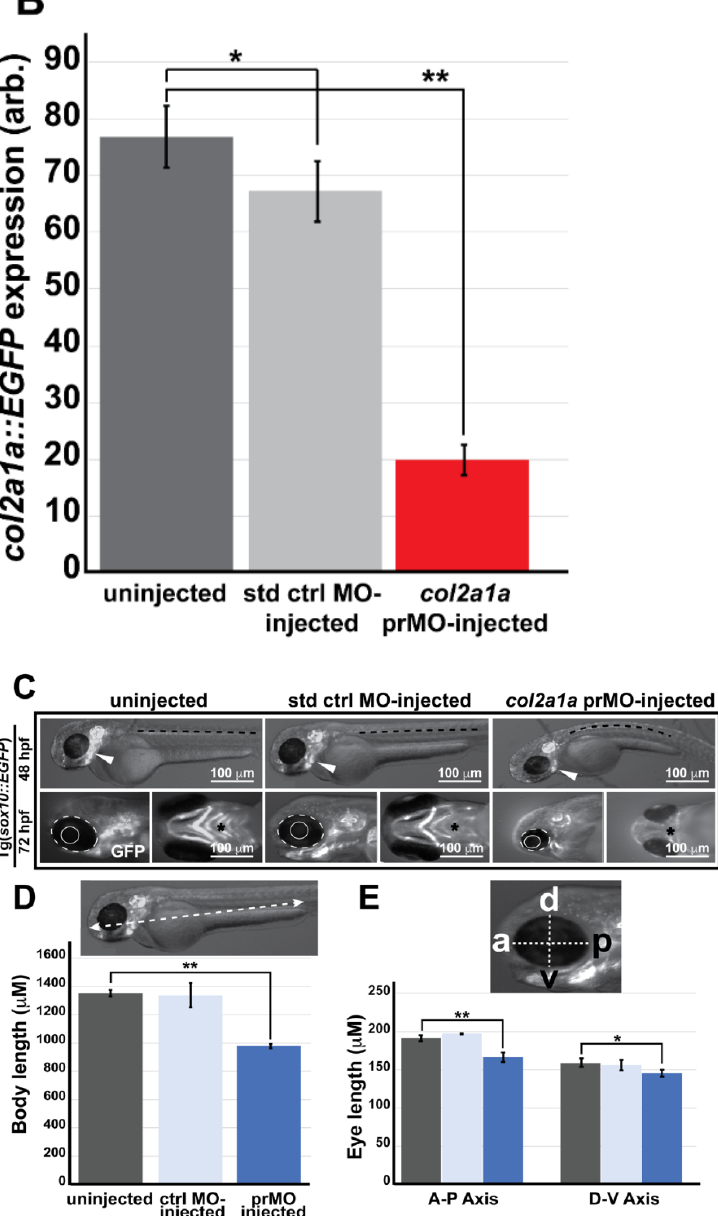
Figure 4. Col2a1a knockdown mimicked the characteristic features of human Stickler syndrome in zebrafish. A lissamine-tagged antisense MO targeting the promoter region (prMO) of col2a1a was injected into TgBAC( col2a1a::EGFP ) and Tg( sox10::EGFP ) embryos at the single-cell stage. Lateral FL microscopy images ( A ) show the loss of GFP reporter expression driven by the col2a1a promoter in TgBAC( col2a1a::EGFP ) transgenic fish (lower right panel) compared with uninjected and standard control (std ctrl) MO-injected embryos (upper right and middle panels, respectively). Quantification of this effect showed a significant loss of expression ( B ). MO-injected Sox10-positive transgenic zebrafish embryos showed skeletal defects, including scoliosis (upper right panel, dashed black line, ( C )) and significantly shortened body length ( D ), measured perpendicular to the spine from the tip of the epiphysis to the area above the urogenital opening (white dashed arrow (inset, D ), delayed neural crest-derived jaw development (white arrowhead, upper right panel and black asterisk, lower right-most panel, ( C )), and significantly smaller bulging eyes (solid and dashed circles, ( C , E )), as measured along the anterior–posterior (a-p; inset, E ) and dorsal-ventral (d-v; inset, E ) axes, compared with uninjected and std ctrl MO-injected embryos at 48 and 72 hpf (left and middle panels, ( C – E )). *, p -value ≤ 0.05; **, p -value ≤